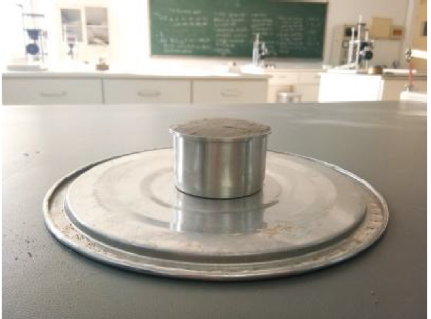
Figure 9: Sample in the soil wreath knife.